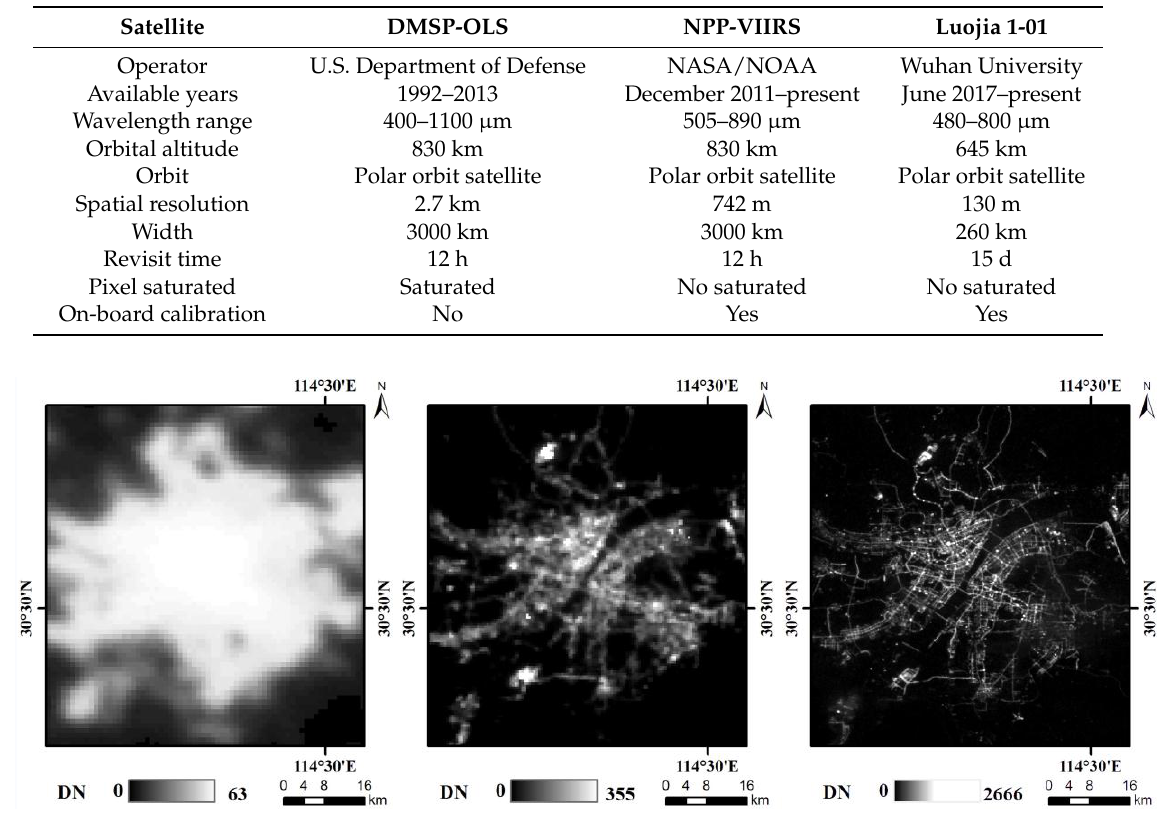
Figure 1. Nighttime imagery from DMSP-OLS, NPP-VIIRS and Luojia 1-01 in Wuhan, China: ( a ) is DMSP-OLS in 2013, ( b ) is NPP-VIIRS in May 2018; ( c ) is Luojia 1-01 on 13 June 2018.